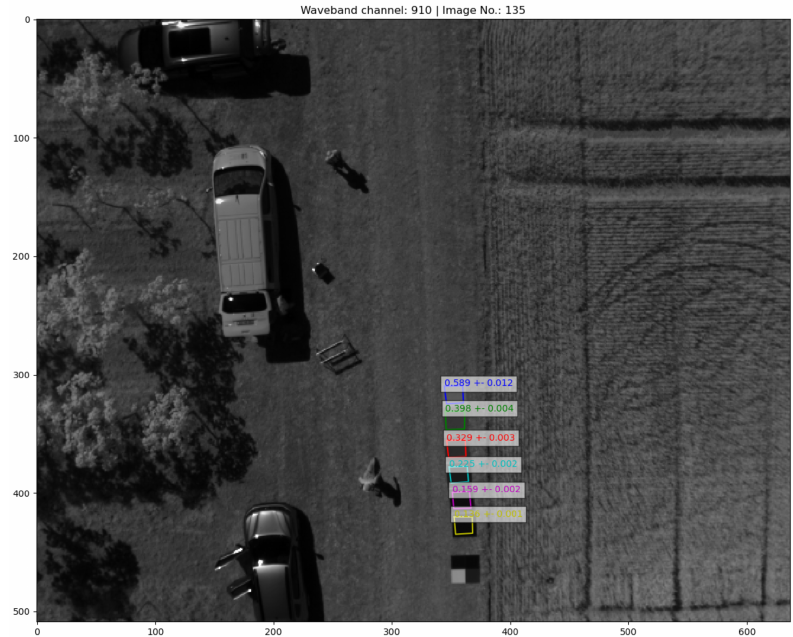
Figure A3. Last step of a developed Python script to determine the averaged pixel values of selected areas. Here the resulting grayscale panels’ reflectance values for one WPM-calibrated image are displayed. The same script is used when determining the average digital numbers of the grayscale panels in the flat-field calibrated images for deriving the transfer function for converting the DN to reflectance